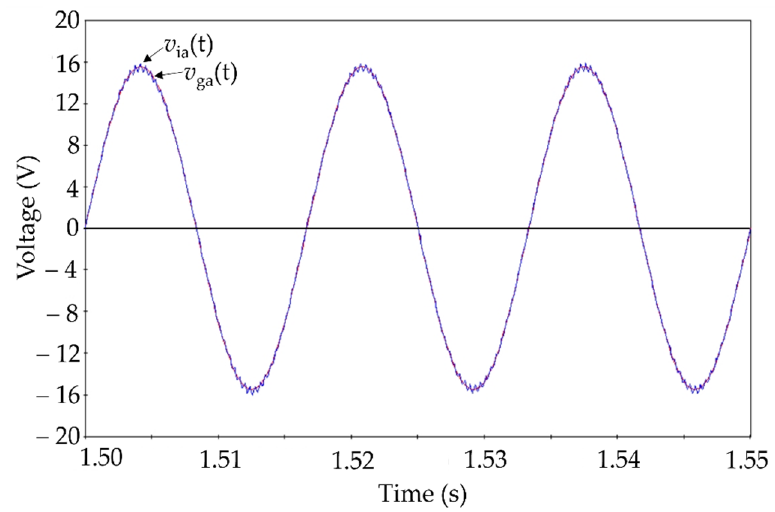
Figure 8. Simulation result of the synchronization case.